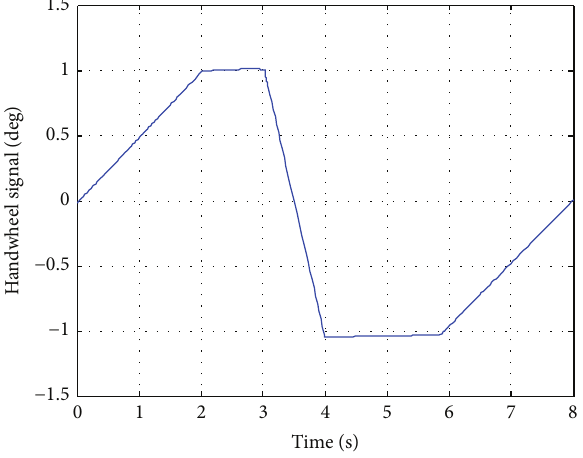
Figure 9: 𝜙 versus 𝑎 𝑦 transient response for 𝜉 = 0.71 .